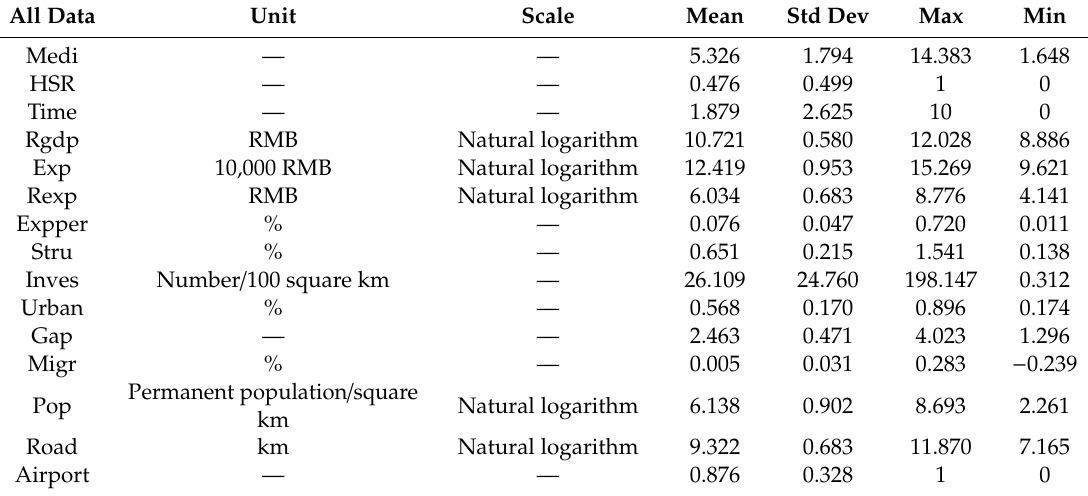
Table 1. Summary statistics for the total sample.